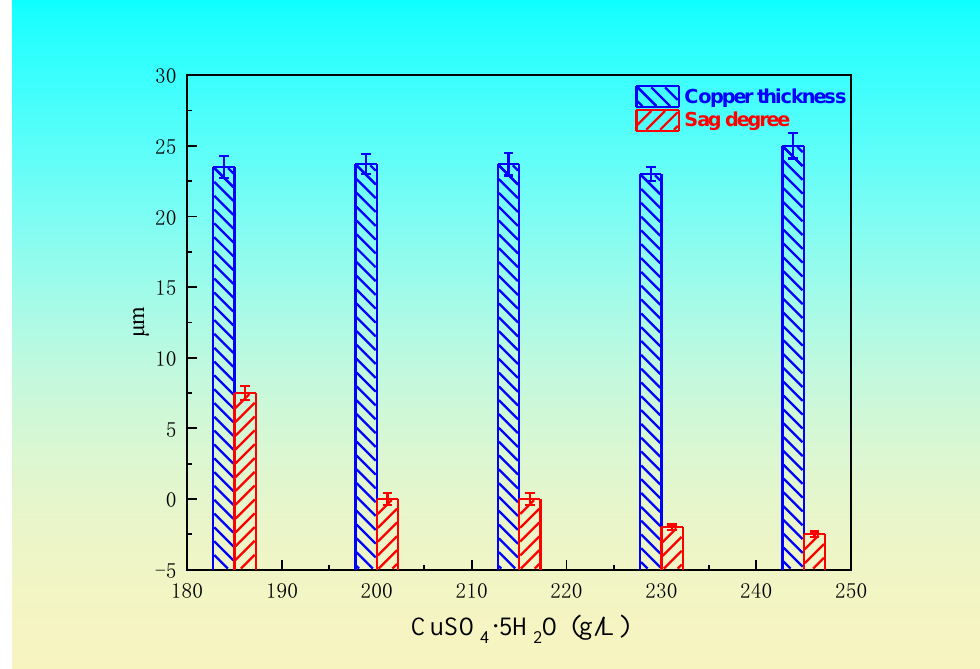
Figure 2. Effect of the copper sulfate concentration on the sag degree and copper thickness. The concentration of sulfuric acid is one of the most important factors affecting the effect of blind hole filling. The increase in sulfuric acid concentration can improve the conductivity and dispersion of the electroplating solution. However, if the sulfuric acid concentration is too high, the leveling agent will be protonated rapidly, which will affect the electroplating effect, and the ductility of the copper coating will be reduced. When the sulfuric acid concentration is too low (<25 g/L), the blind hole filling mode is of an equiangular deposition, which is not conducive to blind hole filling. The relationship between the sulfuric acid concentration and blind hole filling effect is shown in Figure 3 (210 g/L CuSO 4 · 5H 2 O, 45 mg/L Cl − , 15 mL/L leveling agent, 1 mL/L brightener, 10 mL/L wetting agent, 1.5 A/dm 2 current density, and 55 min electroplating ). It can be seen from Figure 3 that when the sulfuric acid concentration is greater than 25 g/L, with the increase of sulfuric acid concentration, the thickness of copper plating layer changes slightly, but the sag gradually increases. When the concentration of sulfuric acid is 25~35 g/L, the sag and the thickness of the copper coating are small. Therefore, the results of the above experimental data show that the blind hole filling effect was good when the optimum concentration of sulfuric acid was 25~35 g/L.